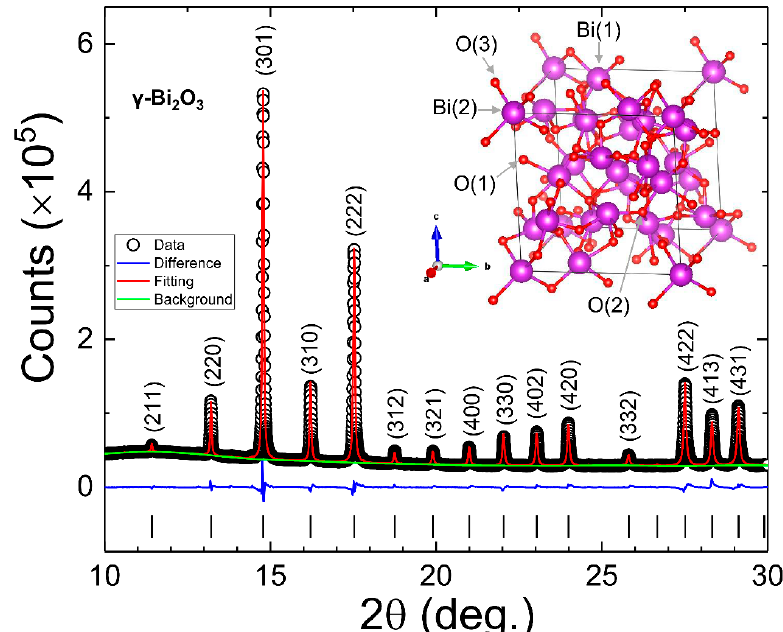
Figure 2. Rietveld refined (red line) PXRD spectra (open dots) of γ –Bi 2 O 3 NPs. Green and blue lines represent the background and difference between observed and fitted PXRD spectra. A unit cell of γ –Bi 2 O 3 is shown in the inset. Table 1. Rietveld refined parameters for XPRD spectra of γ –Bi 2 O 3 NPs. All structural and lattice parameters were allowed to very simultaneously until the weighted wR factor and the goodness of fitting (GOF), differed by less than one part in a thousand in two successive cycles 1 . Sites Table 1. The fitted value of lattice constant a = 10.1115(1) Å (space group I 23, No. 197) with a unit